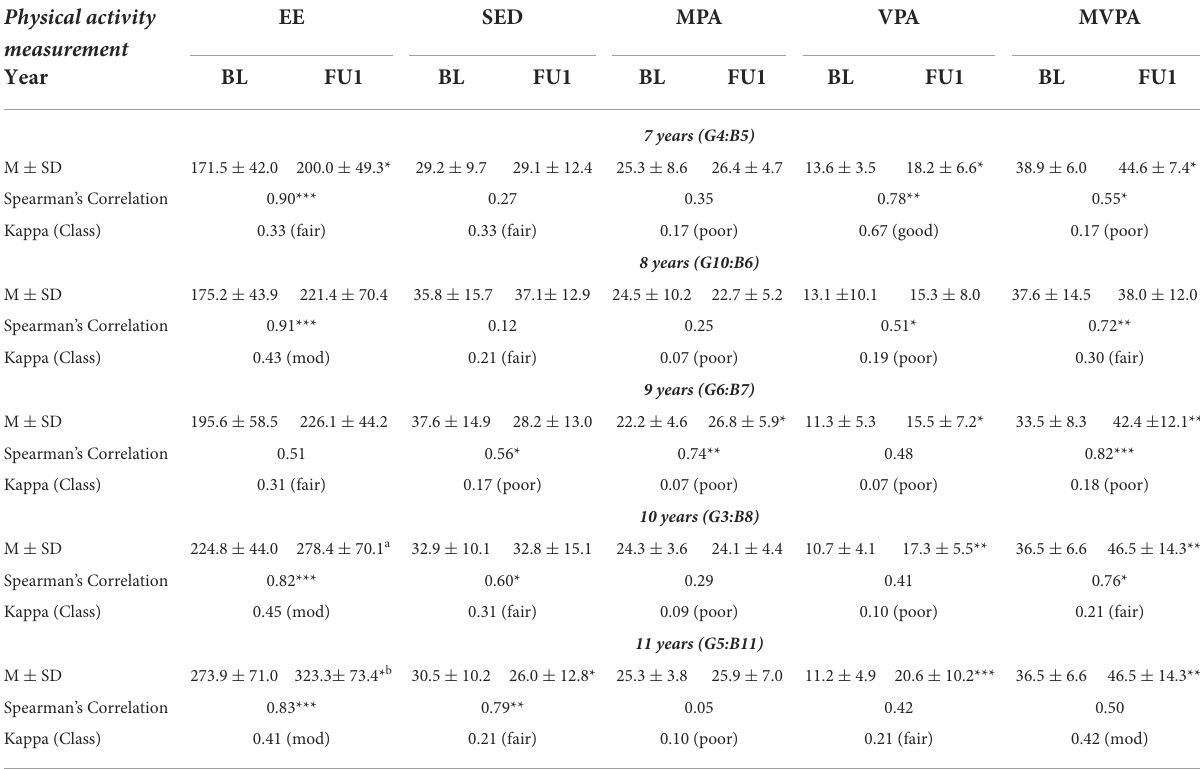
TABLE 3 Age-related means and standard deviations (M ± SD), correlation coefficients, kappa statistics, and kappa classifications for the physical activity measures obtained during summer camps guided active play sessions (55min) at baseline (BL) and 1-year later (FU1). Physical activity